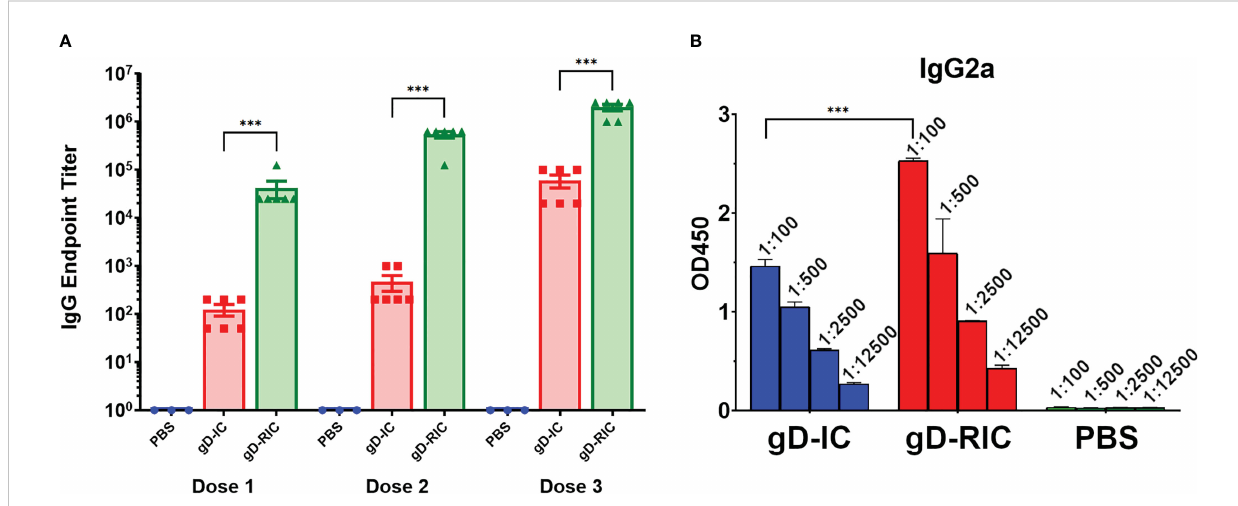
FIGURE 5 Mouse immunization and serum titers. BALB/c mice (6 per group) were immunized three times three weeks apart subcutaneously with a dose that would deliver 4 m g gD for each construct or with PBS as a control. Mouse serum samples was collected on days 28, 56, and 86 for doses 1, 2, and 3 respectively. (A) Serially diluted mouse serum was analyzed for total gD-speci fi c IgG production by ELISA. The endpoint was taken as the reciprocal of the greatest dilution that gave an OD 450 reading at least twice the background. Three stars (***) indicates p < 0.001 by one-way ANOVA using Tukey ’ s post-test comparing the indicated columns. (B) Dose 3 mouse serum samples were serially diluted 5-fold starting at a 1:100 dilution and analyzed for IgG2a production by ELISA. Mean OD450 values from three samples are shown ± standard error. Three stars (***) indicates p < 0.001 by one-way ANOVA using Tukey ’ s post-test comparing the indicated columns.